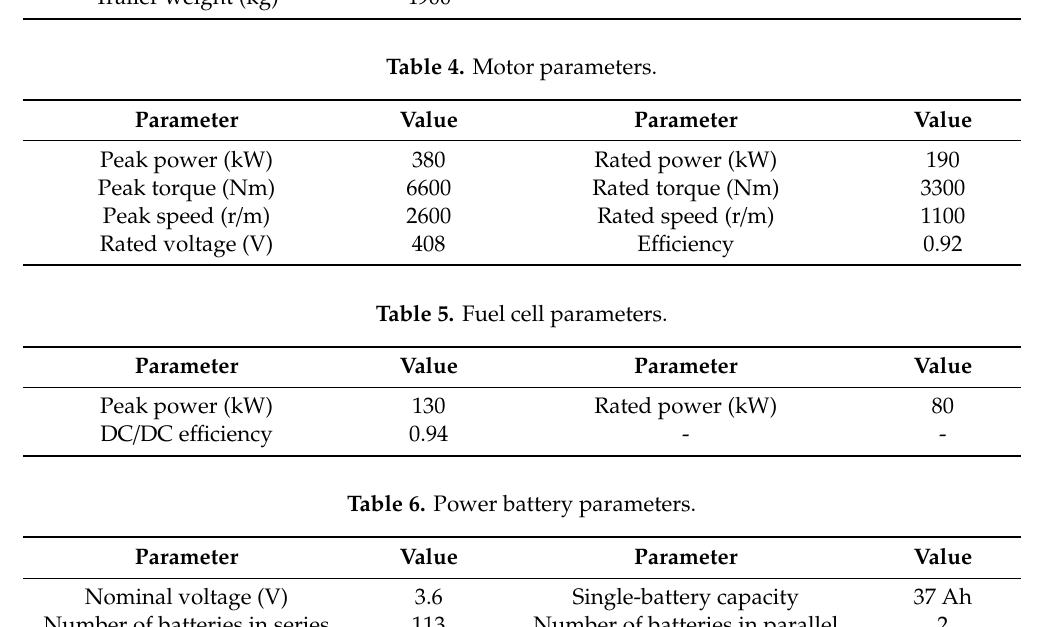
Table 5. Fuel cell parameters.